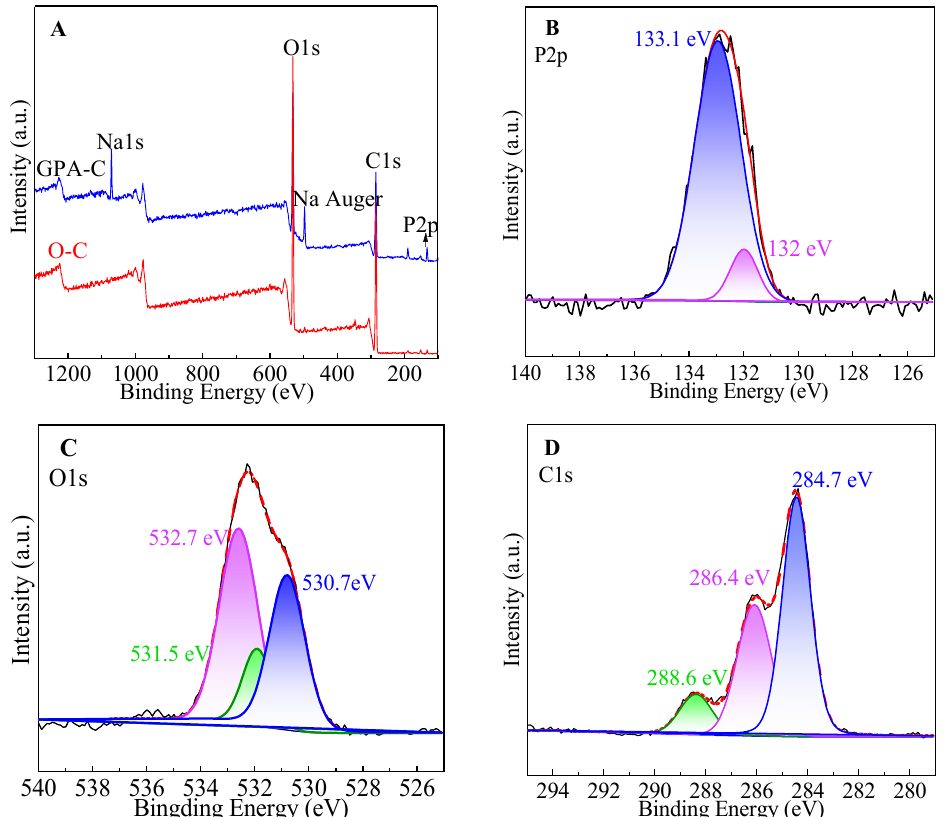
Figure 5. XPS spectrum of fabrics: ( A ) the total electron-binding energy of fabrics; ( B – D ) P, O, and C elements peak division of finished fabric.